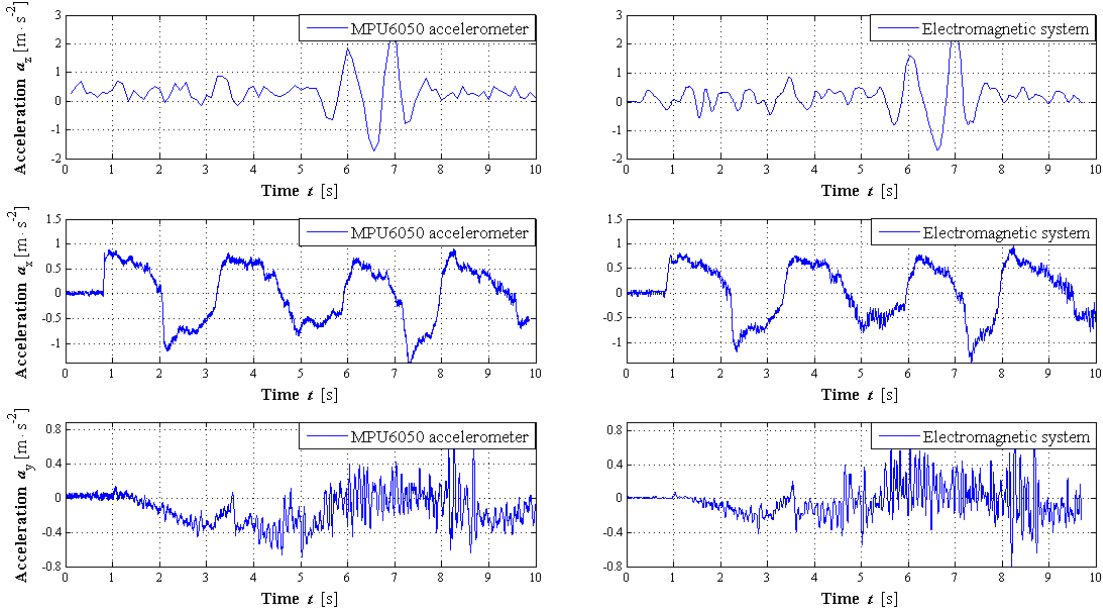
Figure 11. Comparison of measurement waveforms.